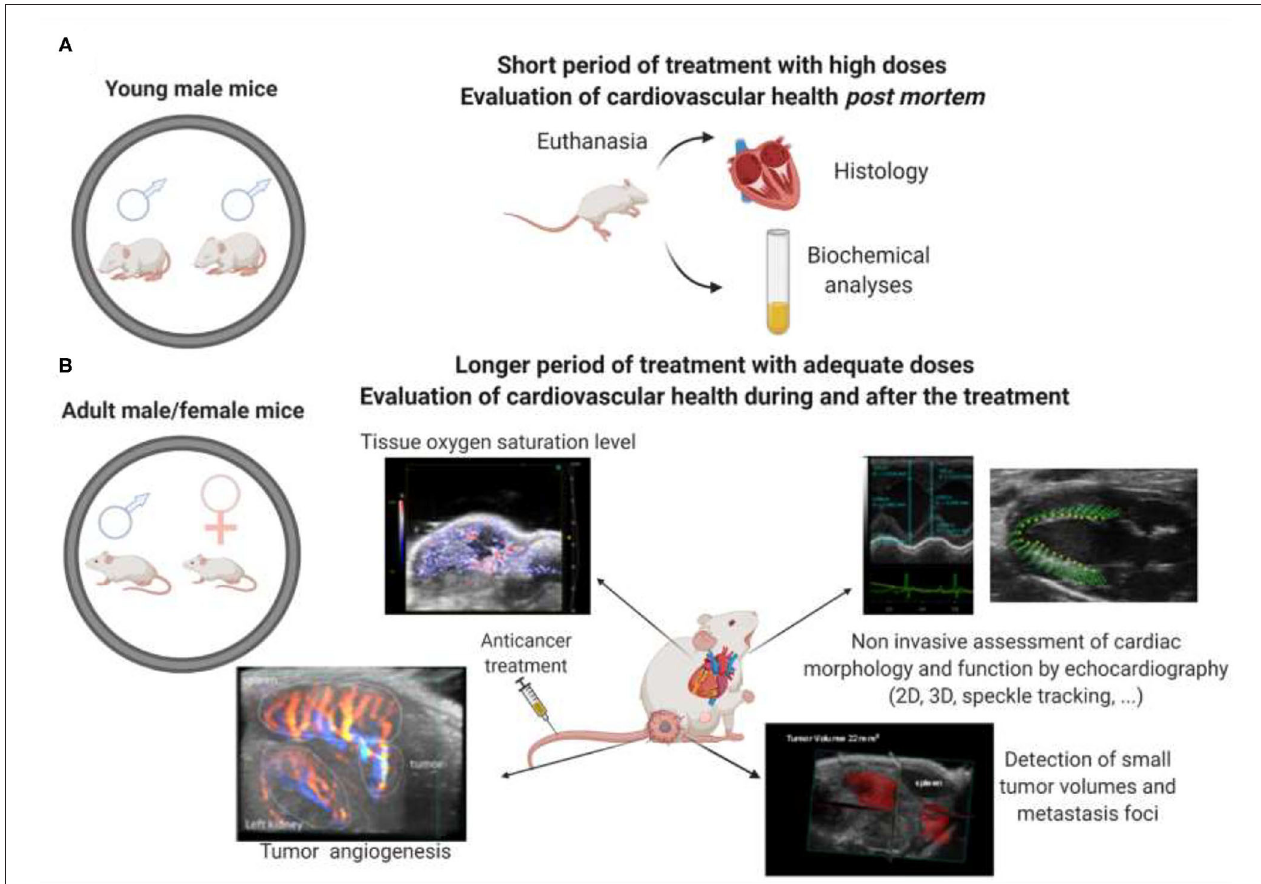
FIGURE 2 | (A) Representation of how anticancer animal studies are generally conducted up to now, with cardiotoxicity evaluation being conducted only after euthanasia of the animals, with high doses administered of the nanocarriers and the use of only male and very young animals; (B) Suggestion of how to conduct animal studies with nanocarriers using both female and male older mice; evaluation of cardiotoxicity during and after the treatment administered with lower doses of the nanocarriers. The ultrasound-based techniques allow the simultaneous evaluation of antitumor activity and